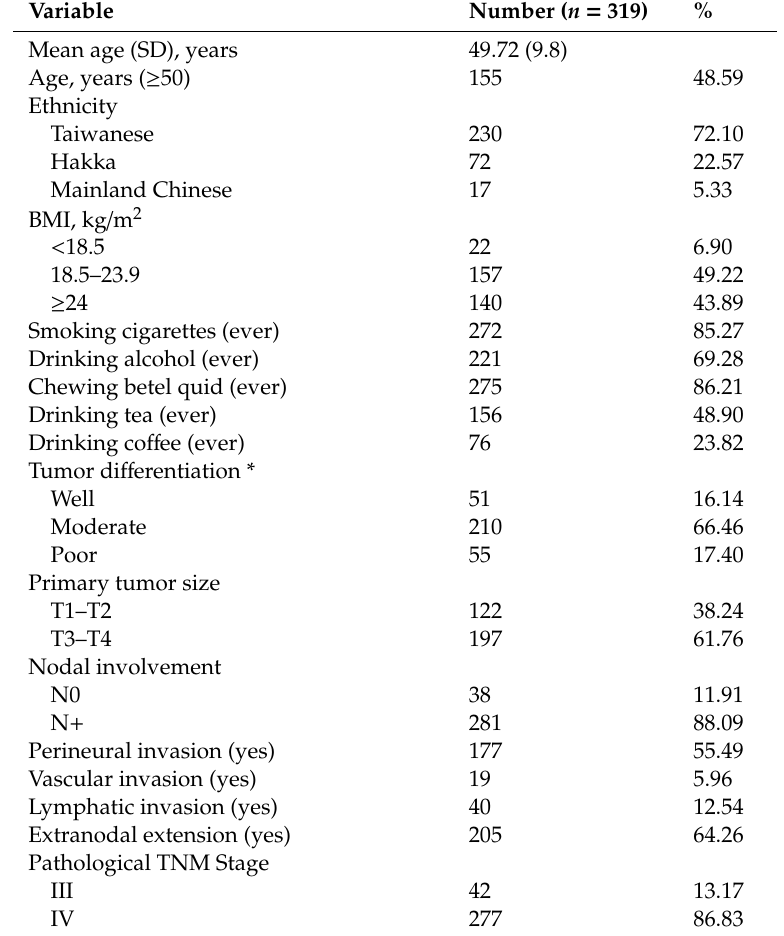
Table 1. Demographic and clinical characteristics of the patients with oral squamous cell carcinoma (OSCC) receiving adjuvant concurrent